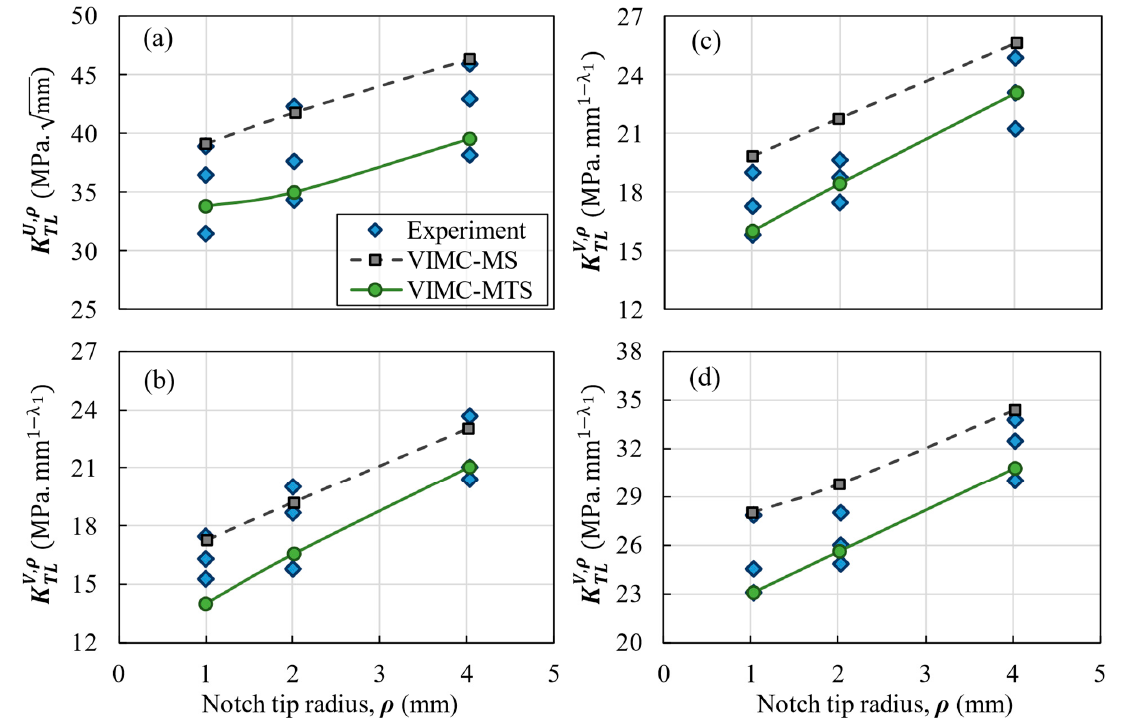
Figure 8. Experimental and predicted TLNFT of the cross-ply laminate versus the notch-tip radius. ( a ) U-notch; ( b ) V-notch with a 30° opening angle; ( c ) V-notch with a 60° opening angle; ( d ) V-notch with a 90° opening angle.